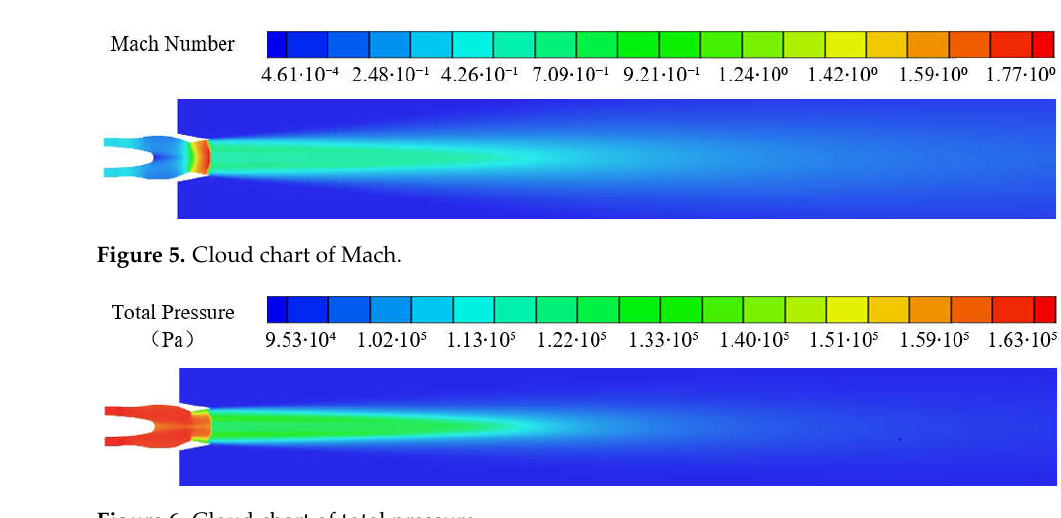
Figure 8. H 2 O mass fraction field distribution.